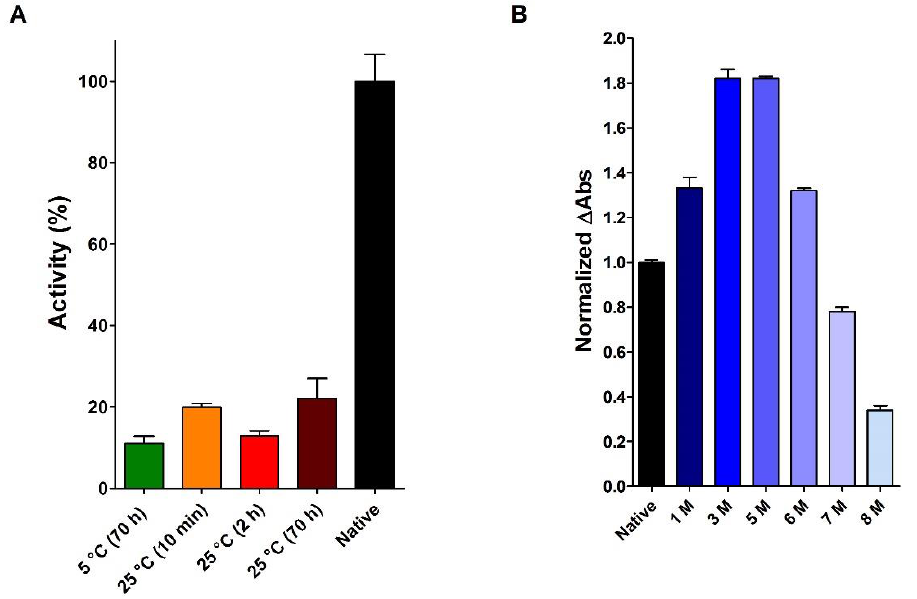
Figure 7. Activity of native RNase (2 µ M) with different urea concentrations. ( A ) Residual activity of native RNase incubated for different times in 8 M urea at different temperatures: 70 h at 5 ◦ C (green column), 10 min. at 25 ◦ C (orange column), 2 h at 25 ◦ C (red column), and 70 h at 25 ◦ C (brown column). The activity of the native protein is also reported (black column). The experiments were performed as described under Materials and Methods. ( B ) Normalized activity of native RNase incubated for 1 h at 25 ◦ C under different urea concentrations from 1 to 8 M urea (six shades of blue columns). All the activities are compared to the activity of the native protein (black column). The experiments were performed as described under Materials and Methods. The error bars represent the S.D. derived from three independent experiments.